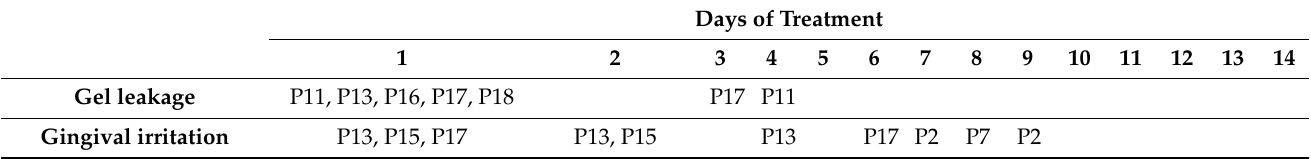
Table 1. Daily report referring to gel leakage and gingival irritation for all 14 days of the treatment duration, for all 20 patients in the